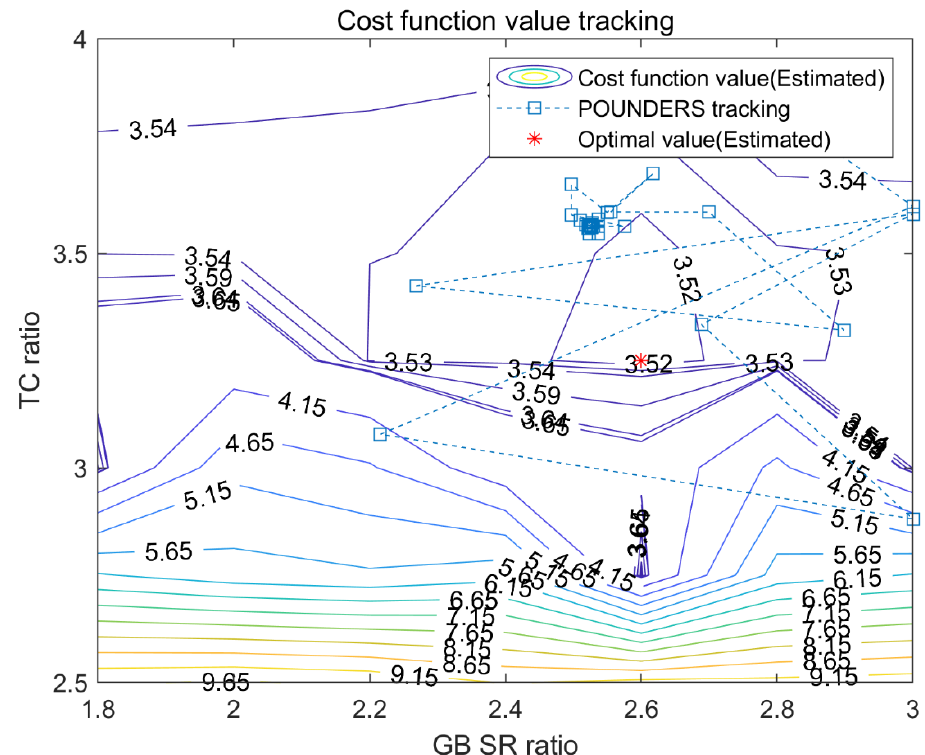
Figure 5. Cost function value contour and parameter optimization history versus TC and GB.